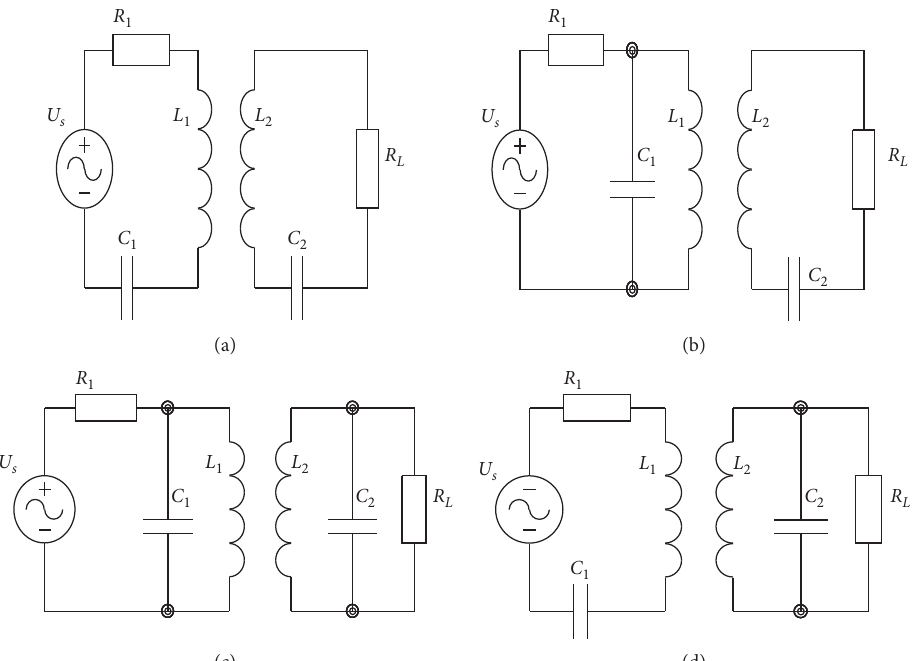
Figure 4: Capacitance compensation circuit. (a) SS structure. (b) SP structure. (c) PP structure. (d) PS